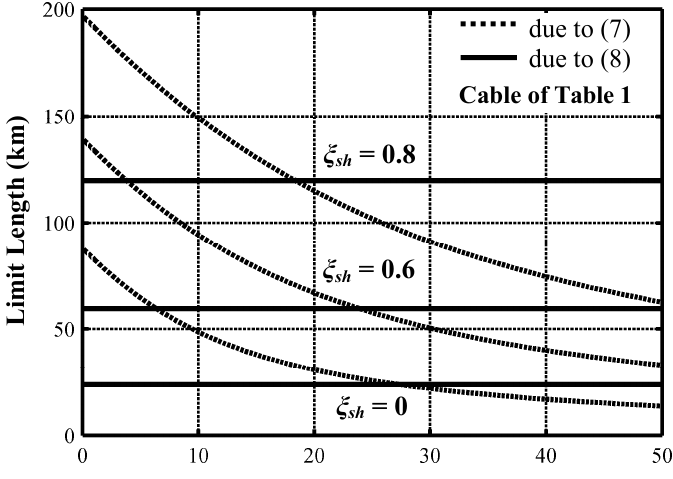
Figure 4. Limit lengths due to the constraints (7) and (8) for cable of Table 1.